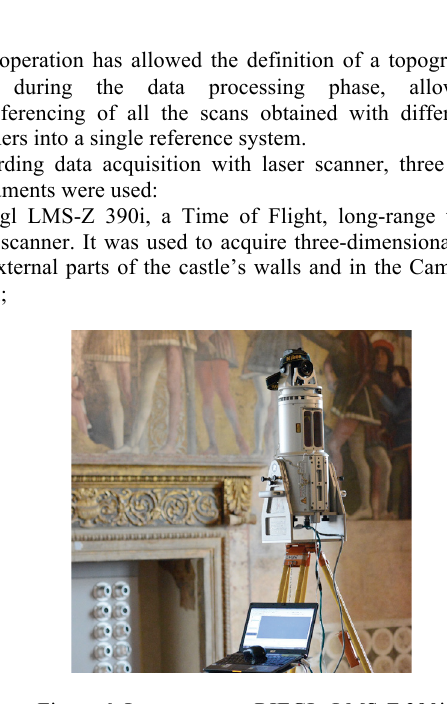
Figure 6. Laser scanner RIEGL, LMS-Z 390i - CAM2, FARO FOCUS 3D, a phase-based terrestrial laser scanner, used for the scans of all the interiors;